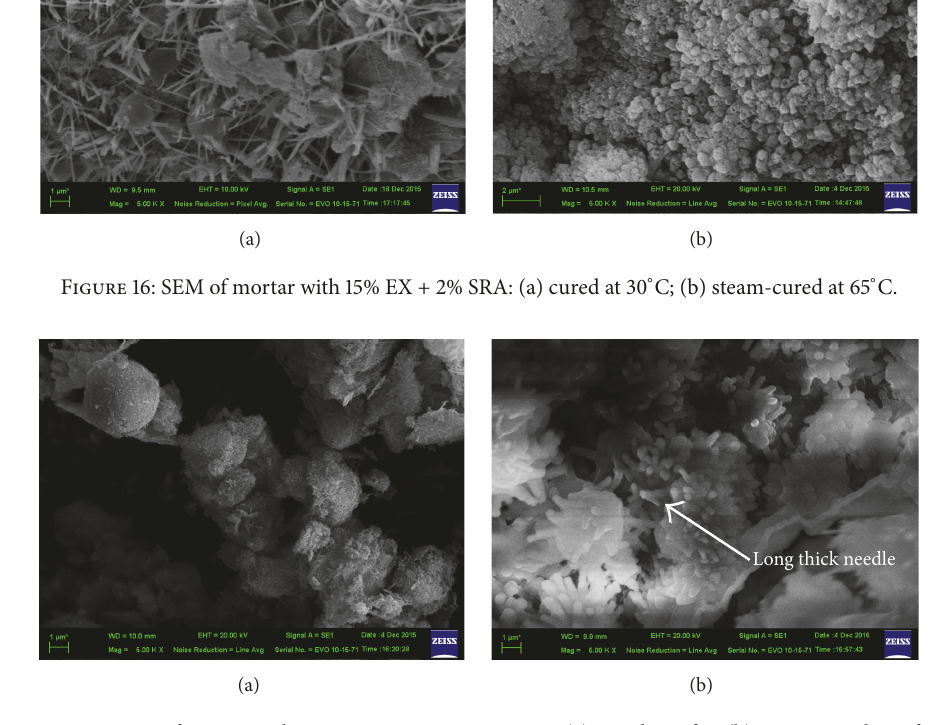
Figure 17: SEM of mortar with 15% EX + 2% SRA + 40% FA: (a) cured at 30 ∘ C; (b) steam-cured at 65 ∘